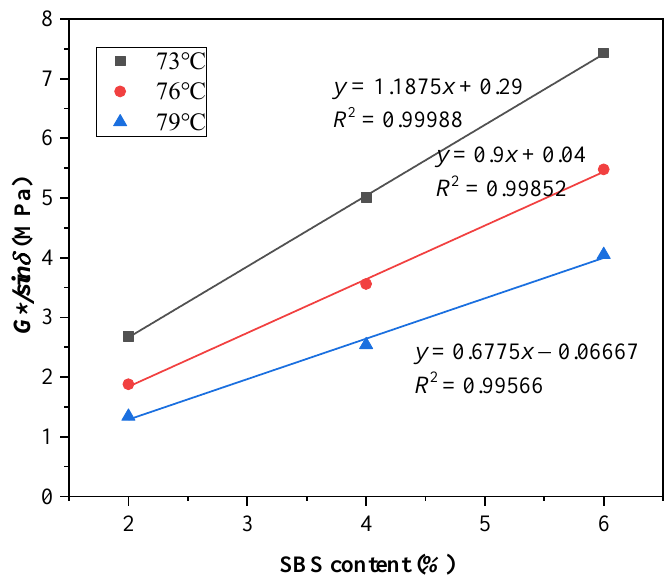
Figure 2. Calibration curves of SBS content based on rutting factor.